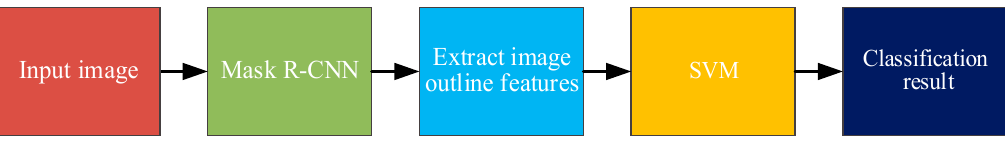
Figure 1. Algorithm flow chart. SVM: Support Vector Machine.